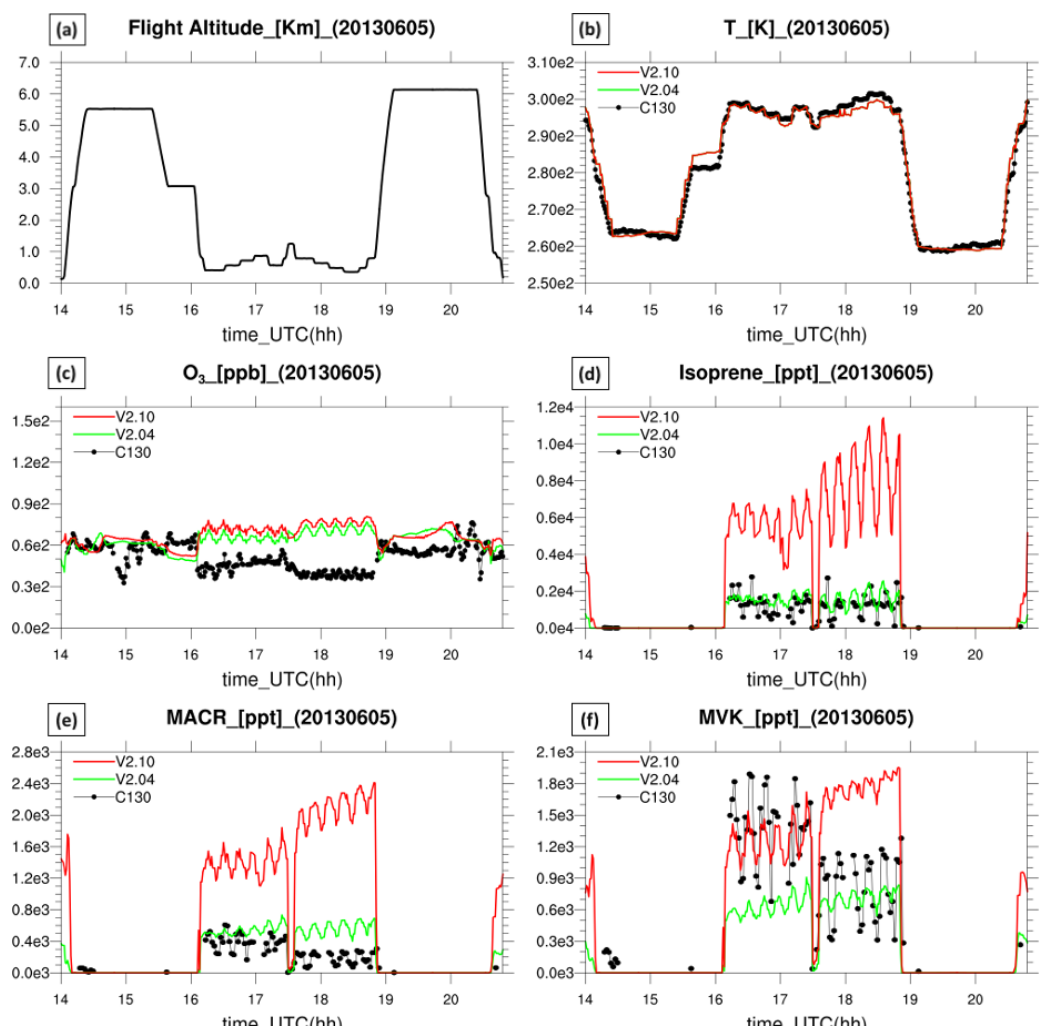
Figure 18. The flight altitude ( a – km), temperature ( b – K), and concentration of isoprene ( c – ppb), methacrolein (MACR) ( d – ppb), methyl vinyl ketone (MVK) ( e – ppb), and ozone ( f – ppb) for the second NOMADSS flight (rf02). The black line shows the C-130 aircraft measurements, and the green and red lines indicate the WRF-Chem model results using MEGAN version 2.04 (M2.04 run) and MEGAN updated to version 2.10 (M2.10 run), respectively. In panel (b) the green line is not shown since it is overlapped by the red line; they have identical